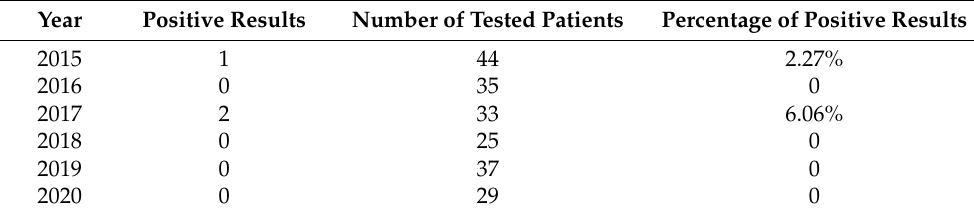
Table 10. Galactomannan Aspergillus antigen in PCICU